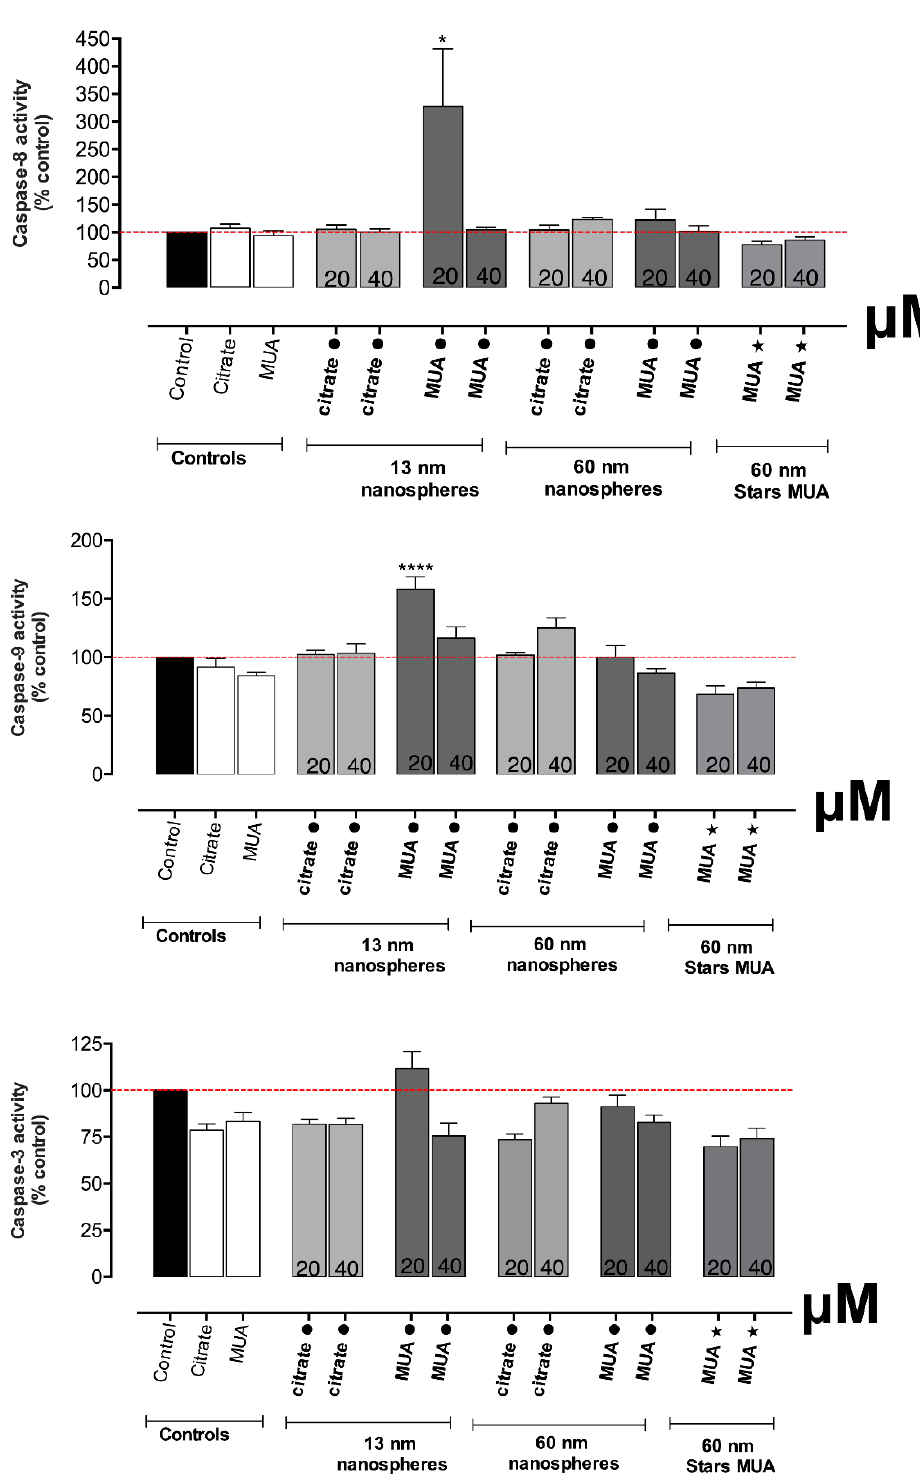
Figure 7. Caspase-8, -9, and -3 activity in HK-2 cells, after 24 h-incubations at 37 °C with AuNPs. Results from three independent experiments are expressed as percentage control ± standard error of the mean (SEM). Statistical comparisons were made using sing one-way ANOVA / Dunnett’s post. * p ≤ 0.05, **** p ≤ 0.0001 versus control.